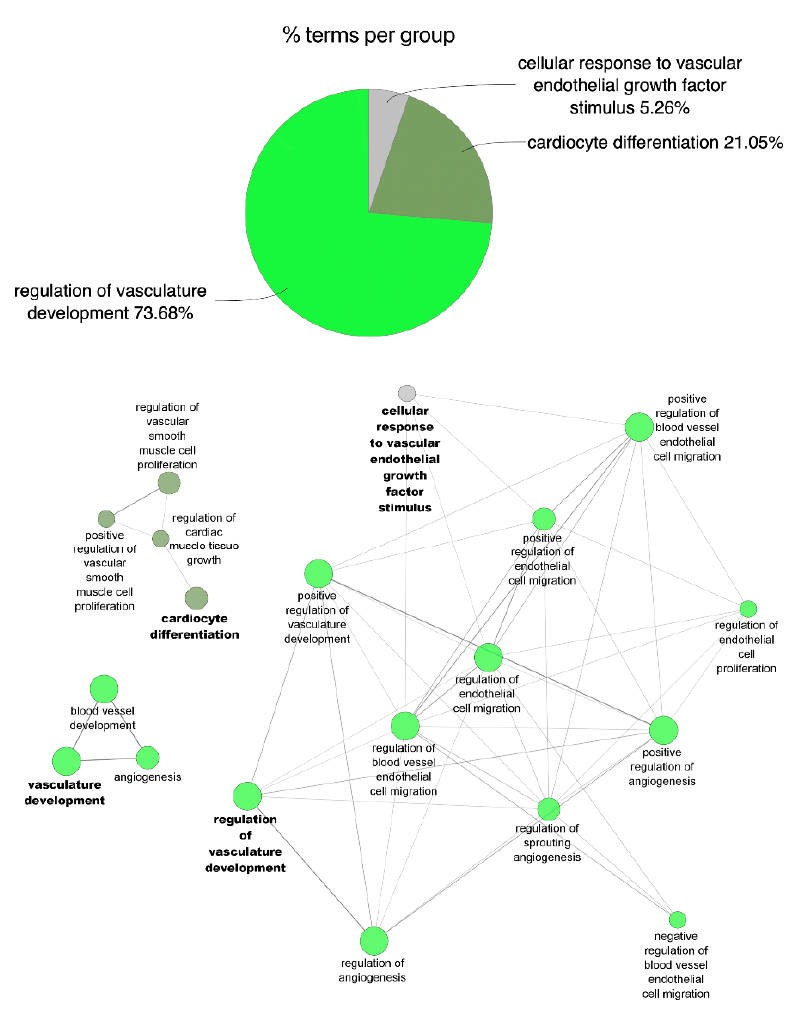
Figure 3. Functional enrichment of miRNA profile and associated biological process in the acute event of acute myocardial infarction (AMI). The pie chart plots the percentage of miRNA-associated functional biological processes that were significantly modified ( p < 0.05, log2 FC ≥ 1/ ≤− 1) in AMI group. Overrepresented Biological Process Gene Ontology (GO) terms are represented as nodes, and node size represents term enrichment significance by Bonferroni test ( p <